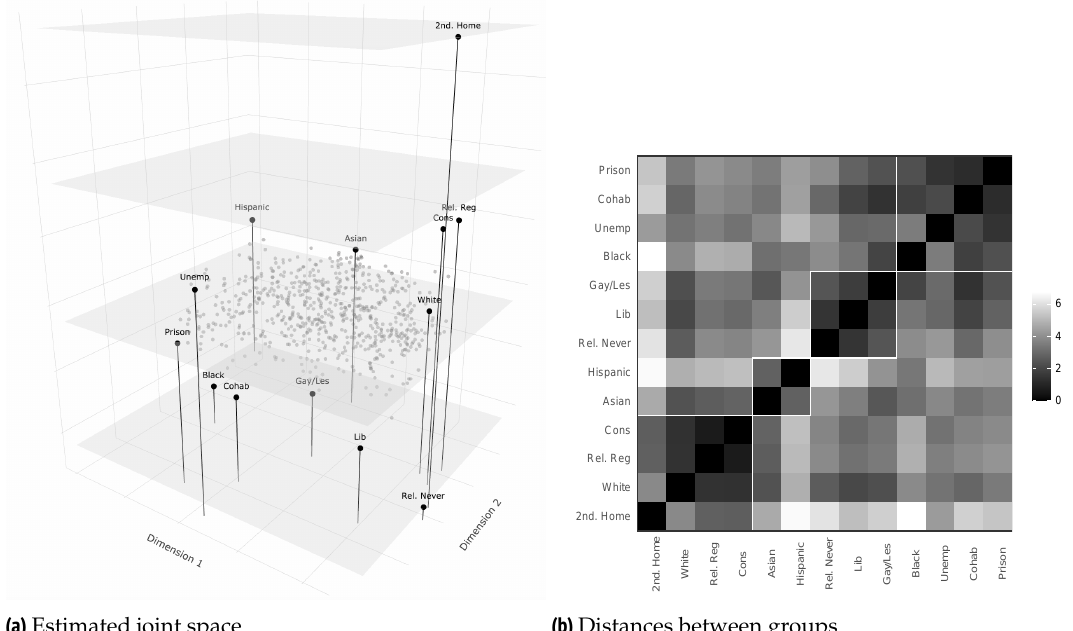
Figure 4: Positions of respondents and groups in social space. Notes: (1) Posterior medians of group positions are shown as black dots in the plot on the left; posterior medians of individual positions are represented by gray dots. (2) Plot on the right shows the posterior median of the between-group distances. Thick white lines represent the clustering results from applying a Gaussian mixture model to the posterior medians of the group